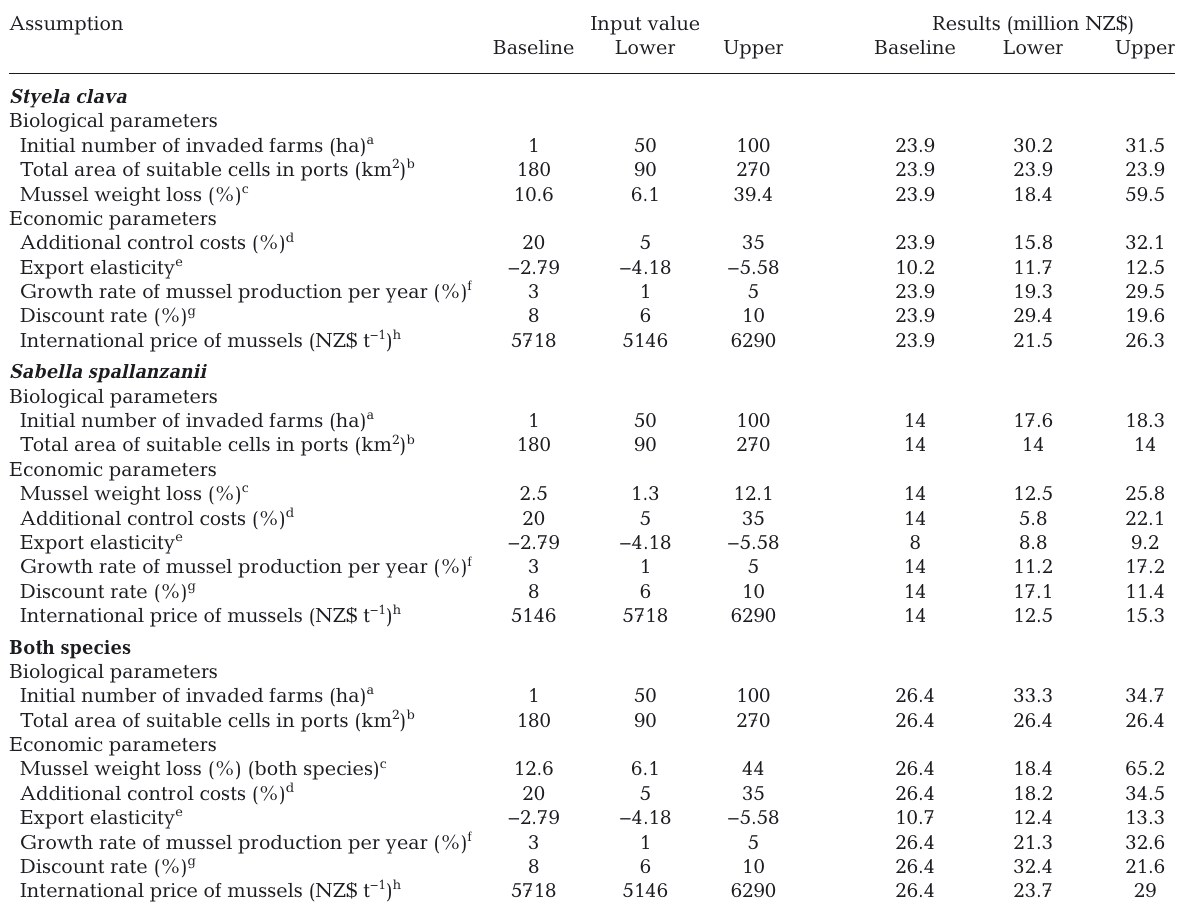
Table 4. Results of the uncertainty analysis for the biological and economic parameters of the bio-economic model for green- lipped mussel culture within a single- and multi-parameter framework. See ‘Methods’ for